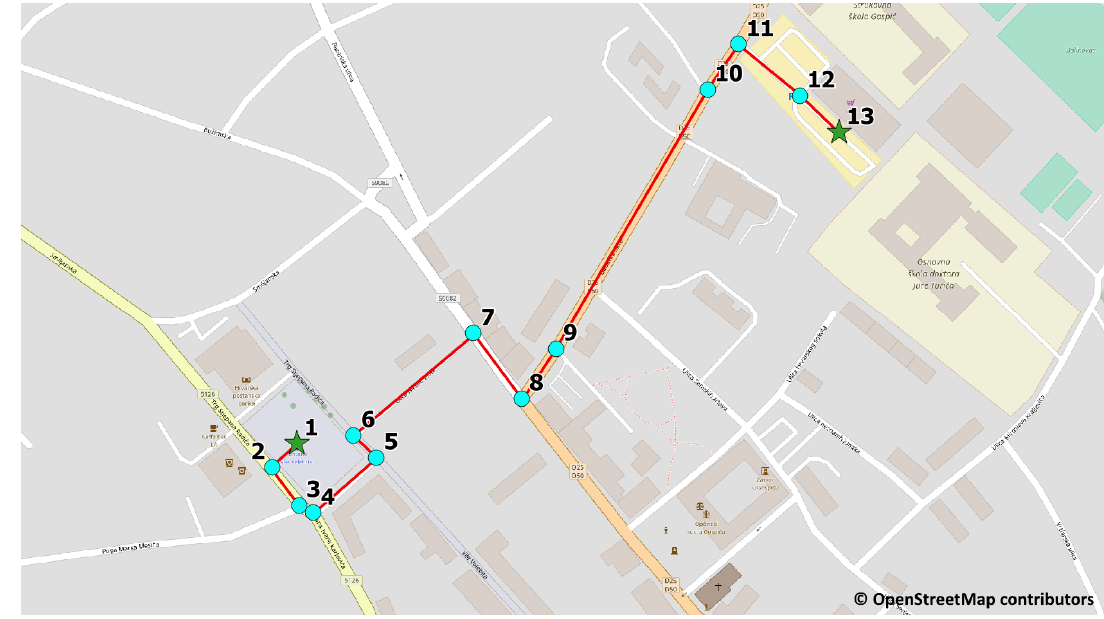
Figure 7. Route generated in Gospić, Croatia (base map © OpenStreetMap contributors).